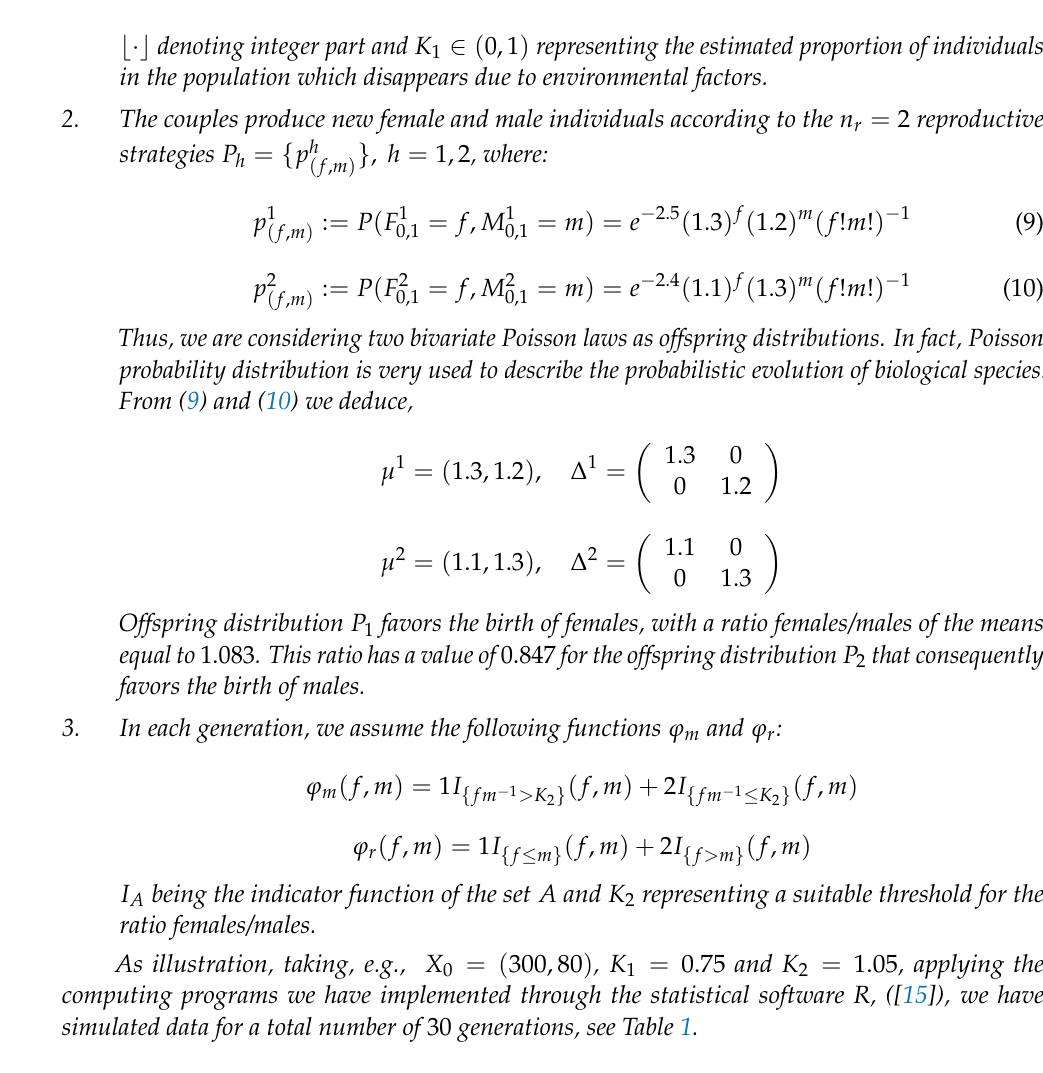
( X n ) ) and reproductive m ( X n )